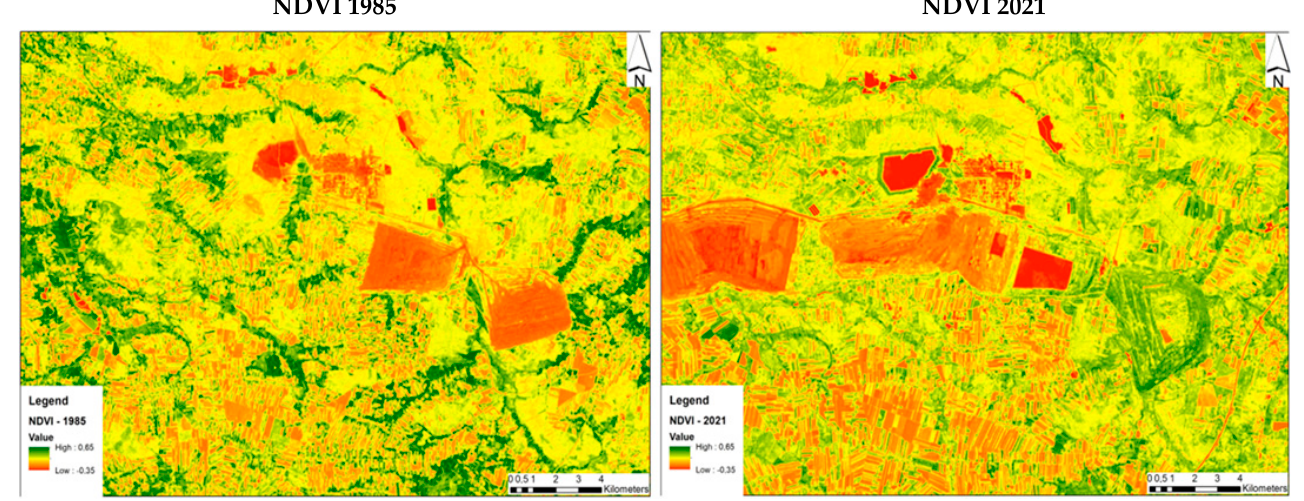
Figure 10. Comparison of NDVI in 1985 and 2021 for the same area of the municipality of Kleszczów (appx. 670 km 2 ). (source: own elaboration based on LandSat data).